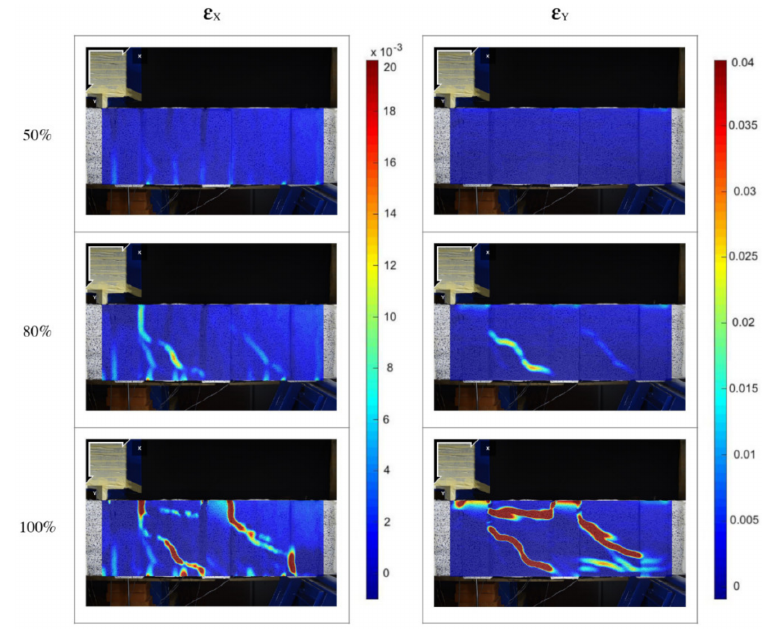
Figure 9. B-D-2L-3S: Strain evolution obtained by using DIC technique. The strain colour maps of the U-Wrapped beam with two layers ( B-D-2L-4S ) is rep- resented in Figure 10. The DIC confirmed how the strips regions’ strains were